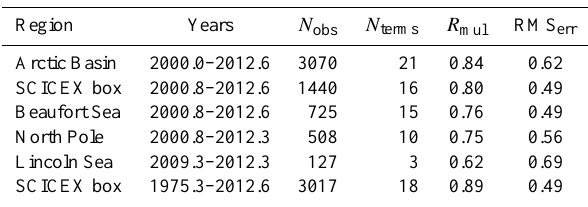
Table 3. The region, time period, number of observations used, number of terms, multiple regression coefficient, and RMS error (m) for each ITRP fit.